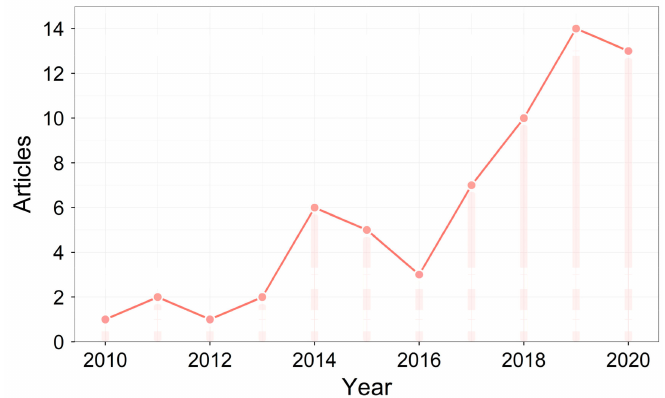
Figure 1. The variations in the number of publications from 2010 to 2020.